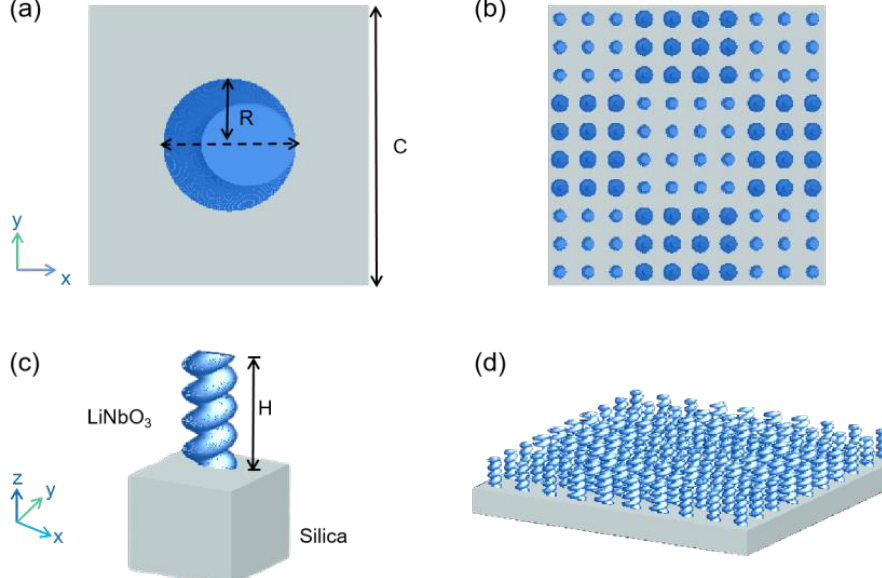
Figure 5. ( a ) Top view of the helical waveguide nanorod cell. ( b ) DG metasurface with two sizes of LN helical waveguide nanorod R 1 = 40 nm and R 2 = 88 nm on the silica substrate. ( c ) Structure diagram of the unit nanorod with size C = 600 nm and height H = 1000 nm. ( d ) The planform of helical waveguide DG metasurface.